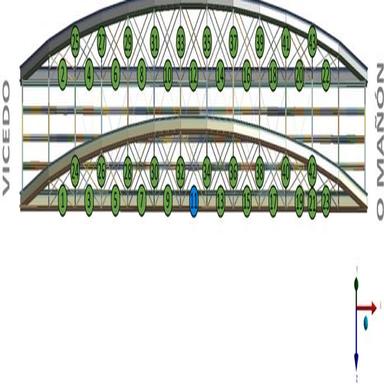
Schematic representation of the accelerometer positions in the ambient vibration test. In blue are the reference sensors, and in green are the roving sensors. (For interpretation of the references to colour in this figure legend, the reader is referred to the web version of this article.)